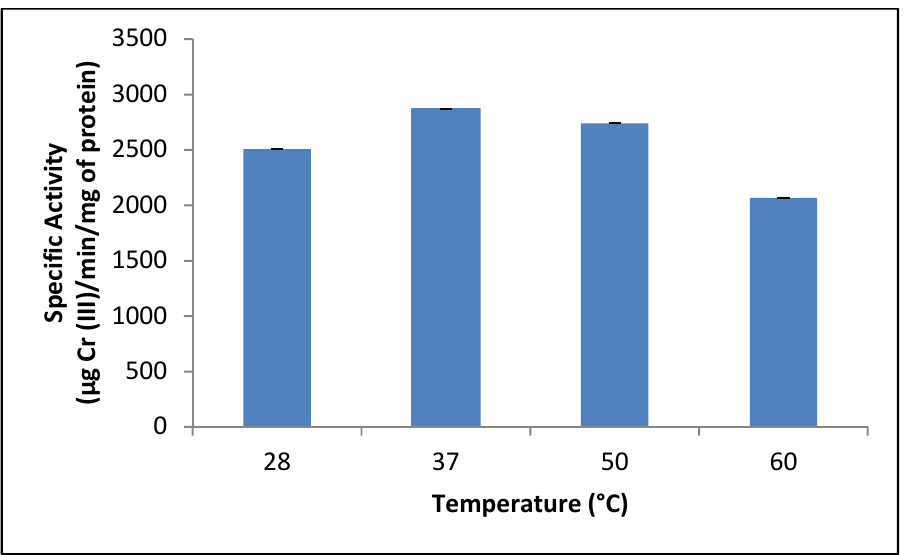
Figure 3. Effect of temperature on crude reductant activity in mixed membrane fraction of Purpureocillium lilacinum . pH 7.0, 1 h of incubation, and 100 rpm.